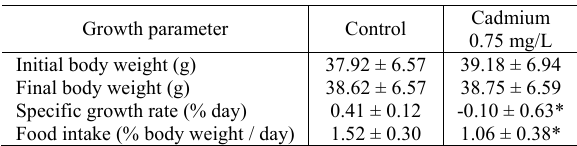
Table 1. Effect of cadmium (CdCl = Statistically different from control, P <